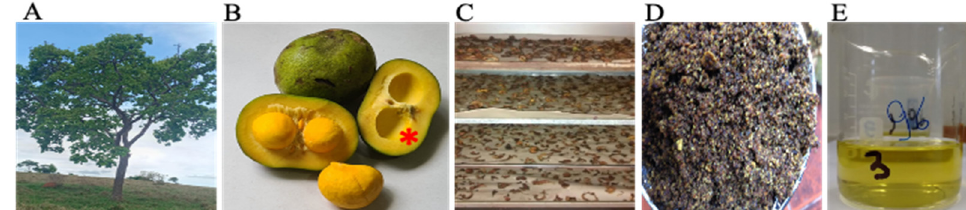
Figure 1. Pequi ( Caryocar brasiliense , Camb.). The tree (left) is native to the Brazilian Cerrado ( A ), a savanna-like biome, with marked dry and wet seasons. The fruit ( B ) is edible and oily and has a thick, dense mesocarp and epicarp (asterisk) that form the bark, which is dried ( C ), macerated ( D ), and percolated in 95% ethanol to extract phenols. After percolation, the ethanol is removed by rotative evaporation (40 °C) and the final product ( E ) is obtained.